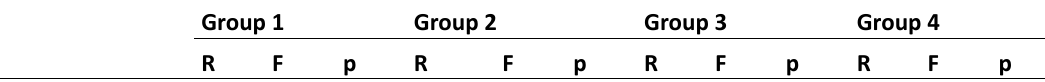
Table 2. Results of the analysis of similarity between experimental and theoretical points calculated using the logistic function